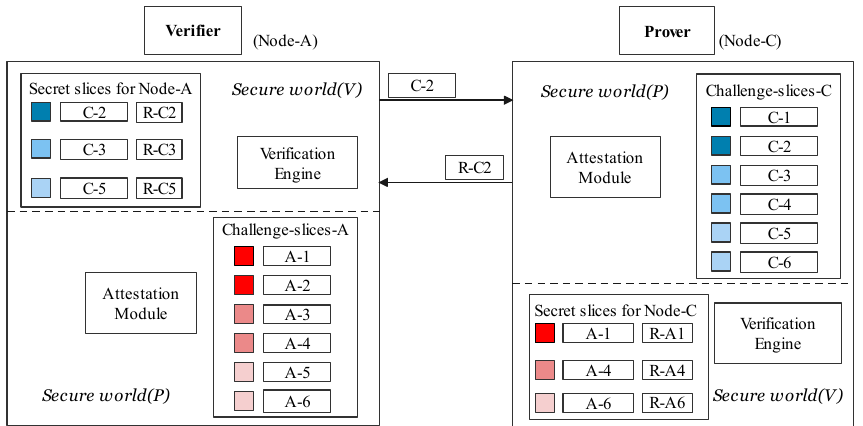
Figure 7. Mutual authentication using secret